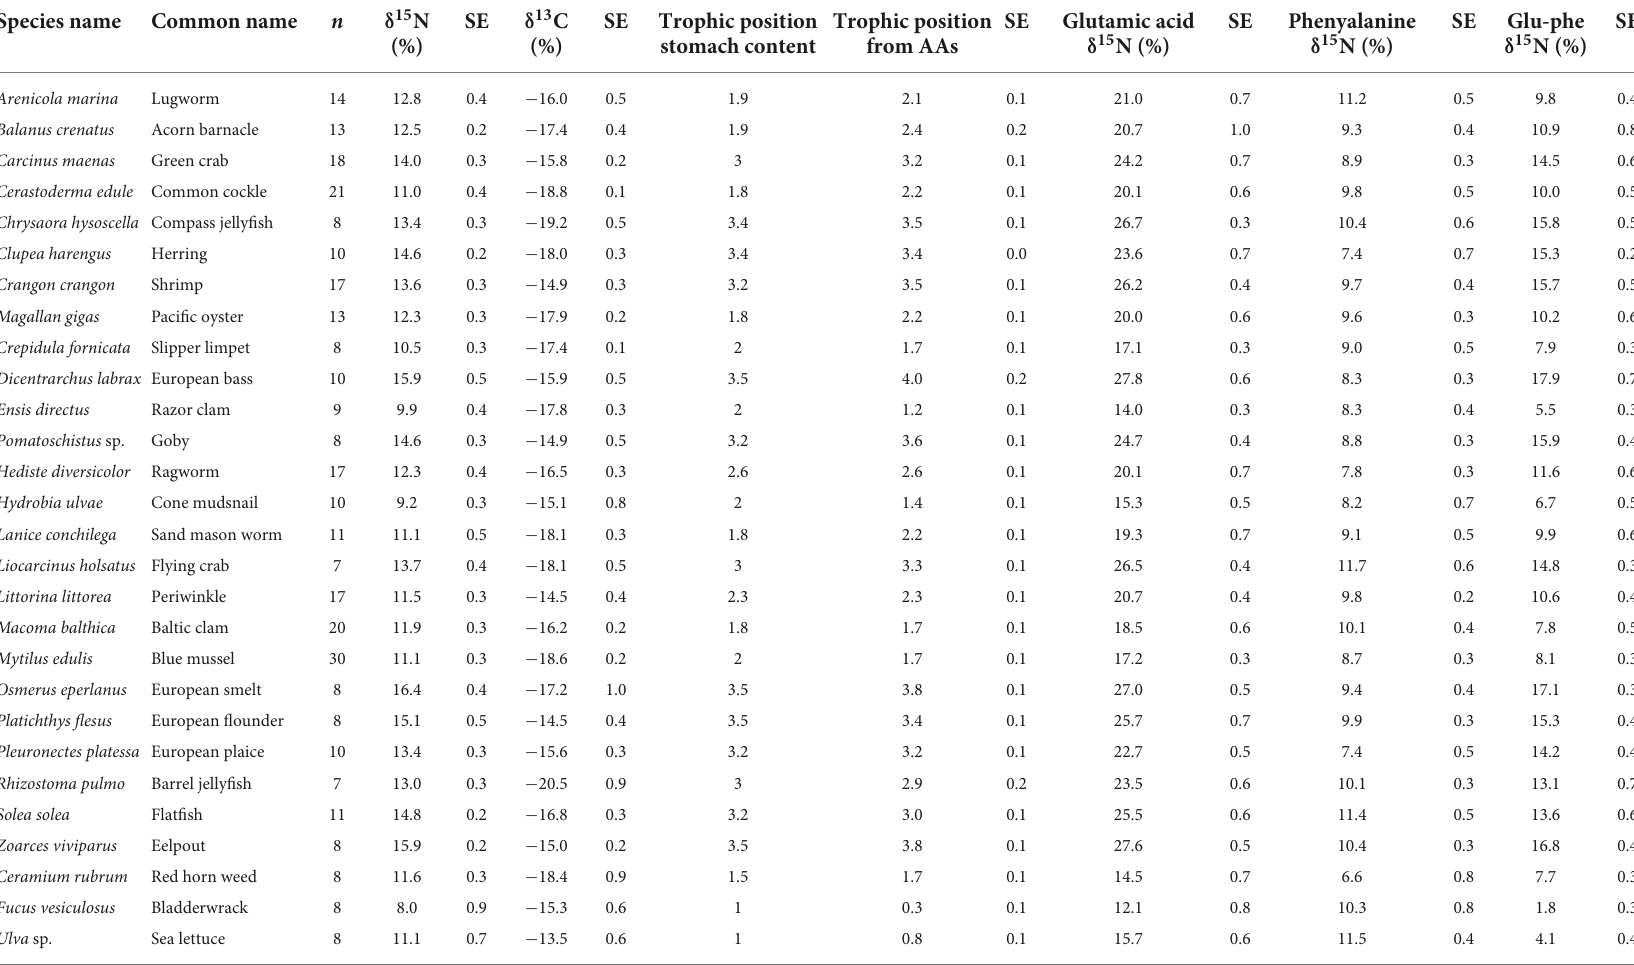
TABLE 1 δ 15 N values for bulk material, glutamic acid, and phenylalanine along with δ 13 C values, trophic position from stomach content and trophic position calculated from amino acids (AAs) for the subset of 25 consumers and three macroalgae species examined in this study sampled from the Dutch Wadden Sea benthic food web during SIBES and Waddensleutels campaigns spanning from 2011 to 2014 and in the NIOZ Fyke during routine